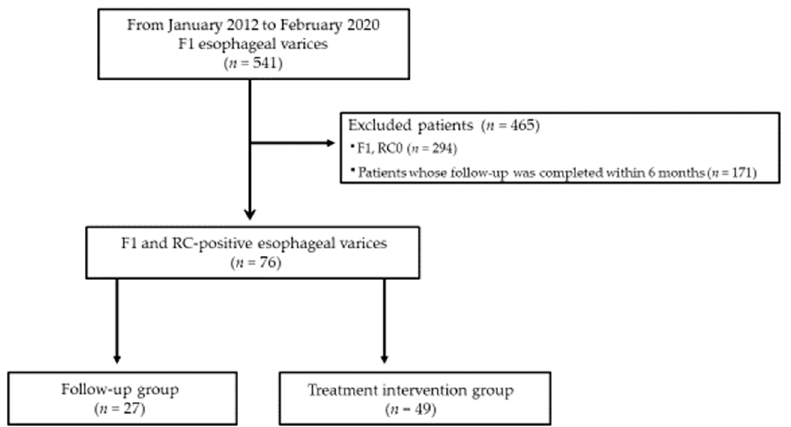
Figure 1. Flowchart showing studied patients.